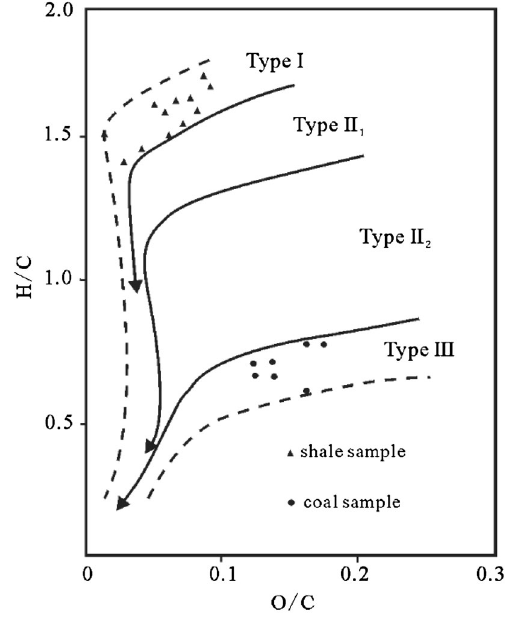
Fig. 3 Van-chart of kerogen plots for the shale and coal samples: H/C versus